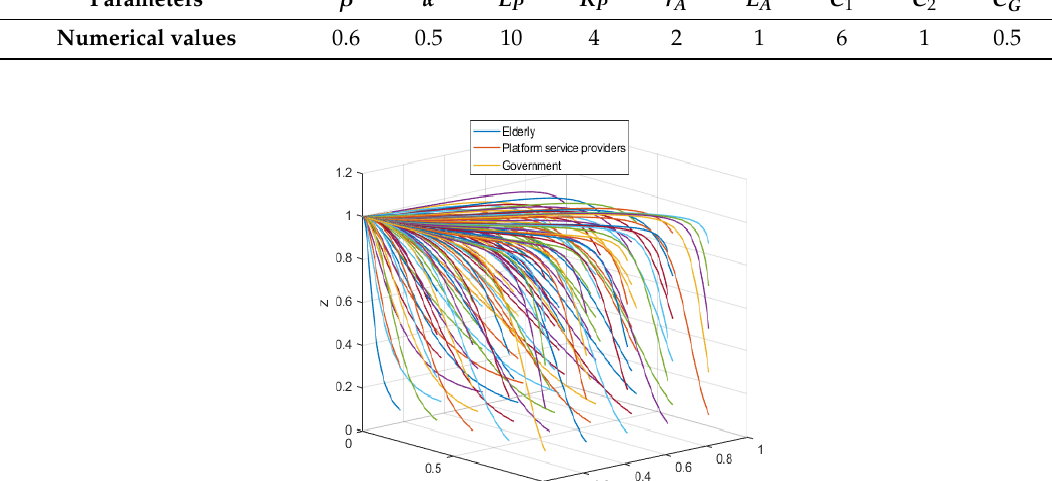
Table 5. Parameter assignment for A 1 ( 0,0,1 ) .